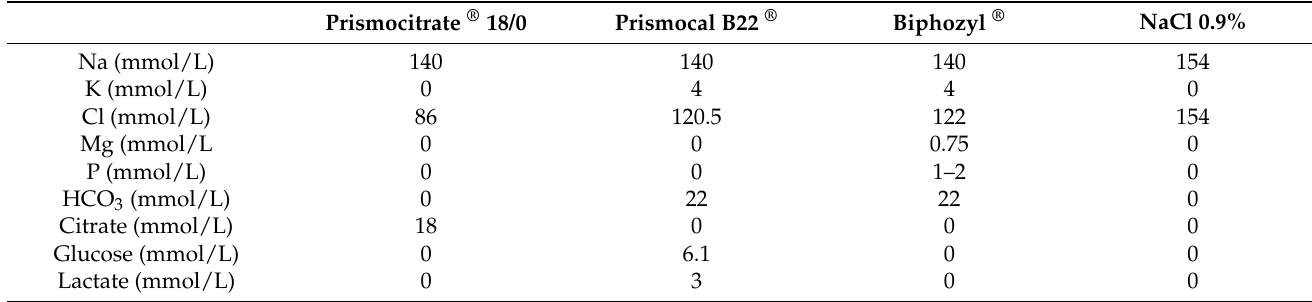
Table 1. Composition of different dialysis